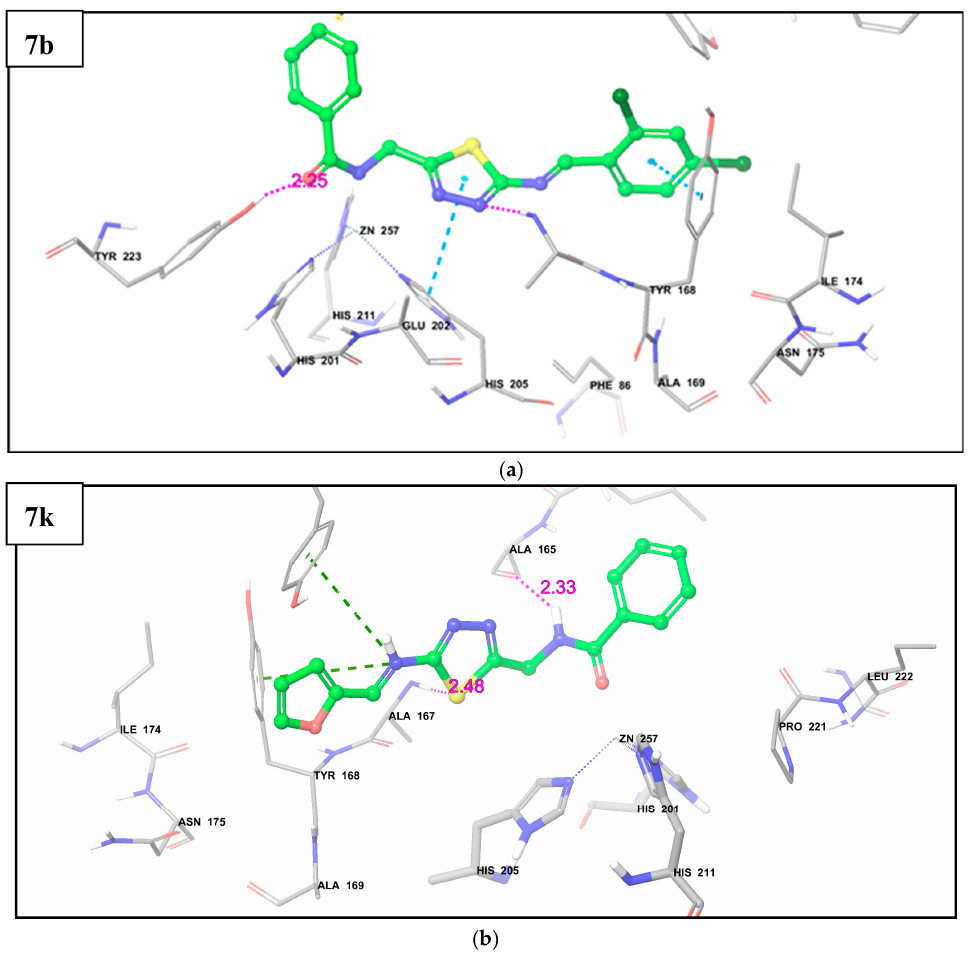
Figure 1. Docking pose of: ( a ) Compound 7b ; ( b ) Compound 7k in the active pocket of Fibroblast stromelysin-1. The pink-colored dotted line indicates H-bond, the cyan-colored dotted line indicates pi-pi stacking interaction, and the green-colored dotted line indicates pi-pi cation interaction between ligand and enzyme.